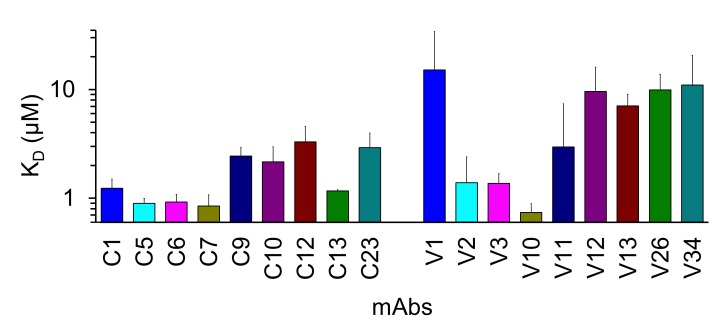
KD values of anti-LigB mAbs.KD values for library C (A) and library V (B) mAbs were calculated by fitting the ELISA-derived dose-dependent binding curves to a dose-response equation using Origin software. Errors for the KD values obtained from nonlinear curve fitting are shown.